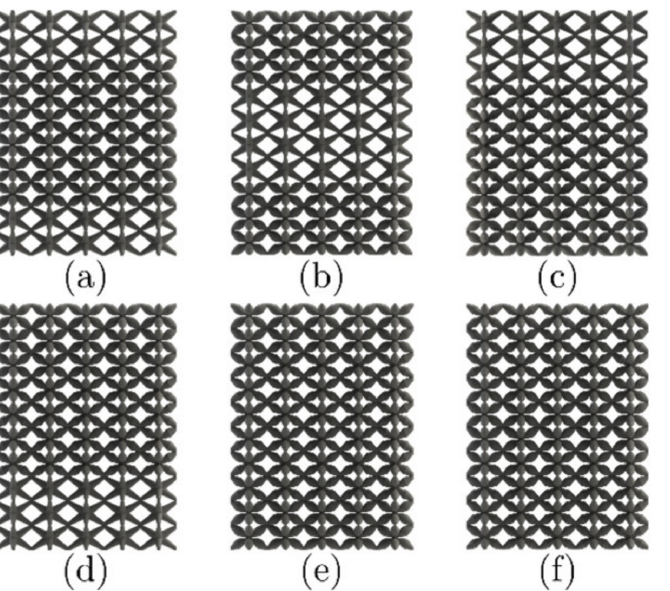
Figure 11. Layered lattice structures. ( a ) HM-LM-HM ( b ) LM-HM-LM ( c ) HM-IM-LM ( d ) LM-IM-HM ( e ) IM-LM-IM ( f ) LM-IM-LM.